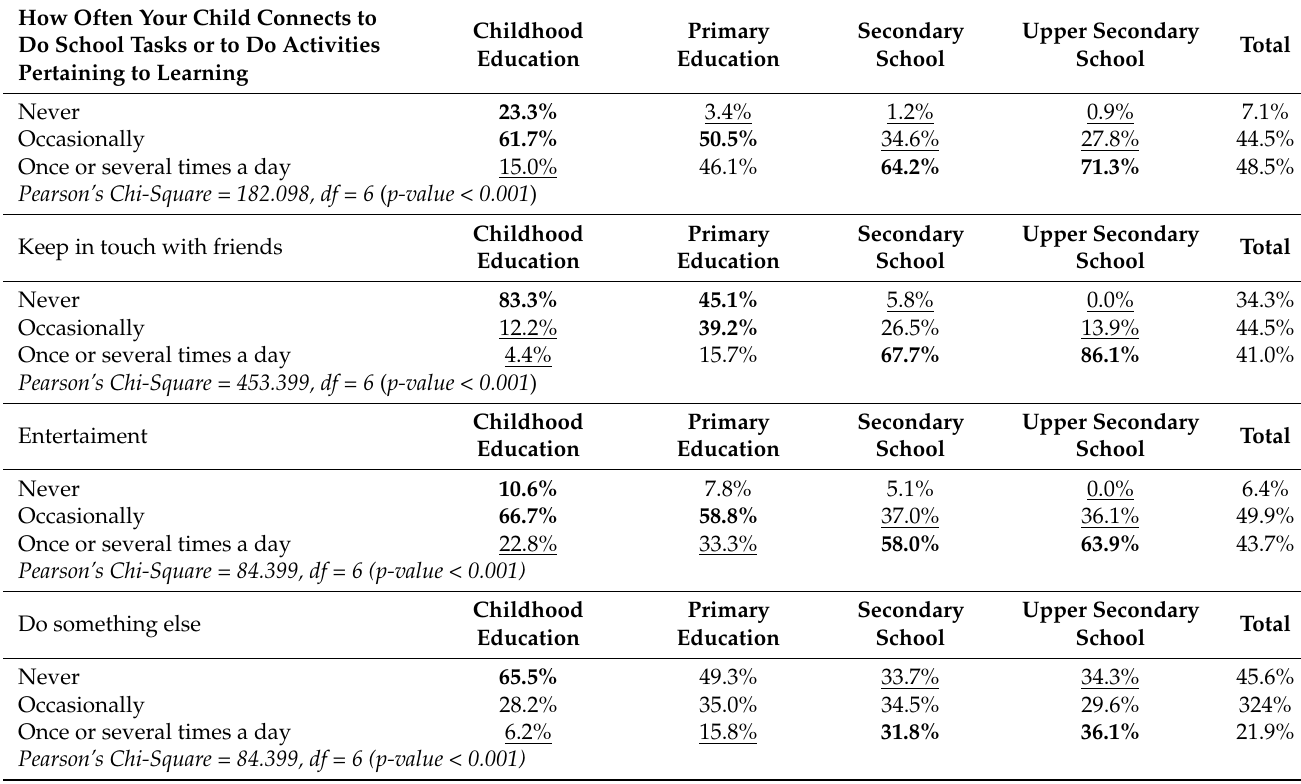
Table 2. Reasons for connecting and frequency of connection by educational